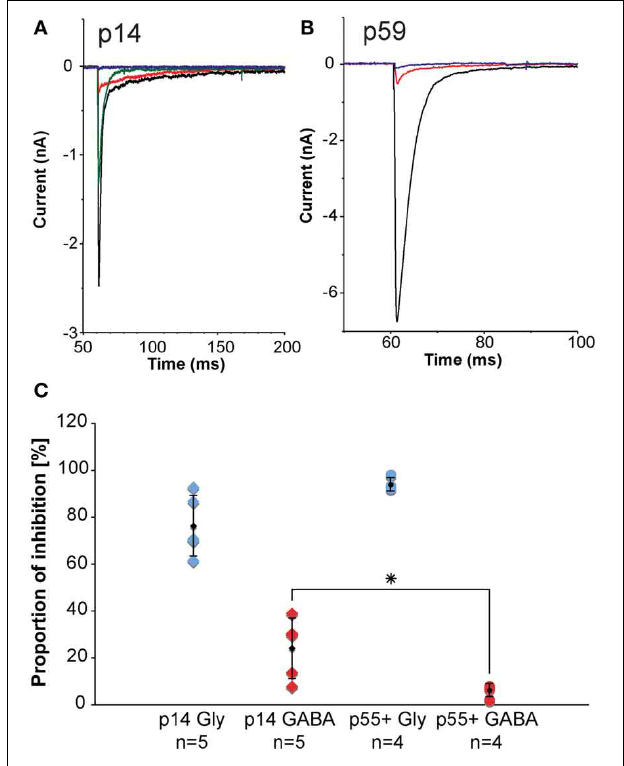
FIGURE 9 | In-vitro electrophysiology in the mouse reveals that the GABAergic contribution to the total inhibition at MNTB principal neurons declines with age. (A,B) are representative examples of pharmacologically isolated inhibitory currents observed in a p14 (A) and a p59 (B) mouse and measured while inhibitory synapses were electrically stimulated in the vicinity of the MNTB principal neuron. The black trace is the total inhibitory current following electrical stimulation, the red trace shows the residual GABAergic current after blocking the glycine component with strychnine, the blue trace is the complete block after an additional wash-in of SR-95531 (gabazine). The green trace shows a partial recovery after a successful washout of both drugs. (C) Normalized current amplitudes for glycine currents suggest a developmental decline of the GABAergic contribution to the total inhibition. Blue diamonds: normalized glycinergic currents measured from p14 animals; blue dots: normalized glycinergic currents measured from p55 + animals; red diamonds: normalized GABA currents measured from p14 animals; red dots: normalized GABA currents measured from for p55 + animals; black symbols: averages with error bars (SD). The GABA component declines significantly with age from almost 25% of total inhibitory current at postnatal day 14 down to about 6% in adult animals, whereas the glycine component does not experience statistically significant changes. All excitatory currents were blocked during these experiments with the glutamate receptor blockers DNQX and AP-V. All recordings were done near physiological temperature (35–37 ◦ C), which significantly speeds up channel kinetics (Leao et al., 2005). ∗ The p -value is 0.032